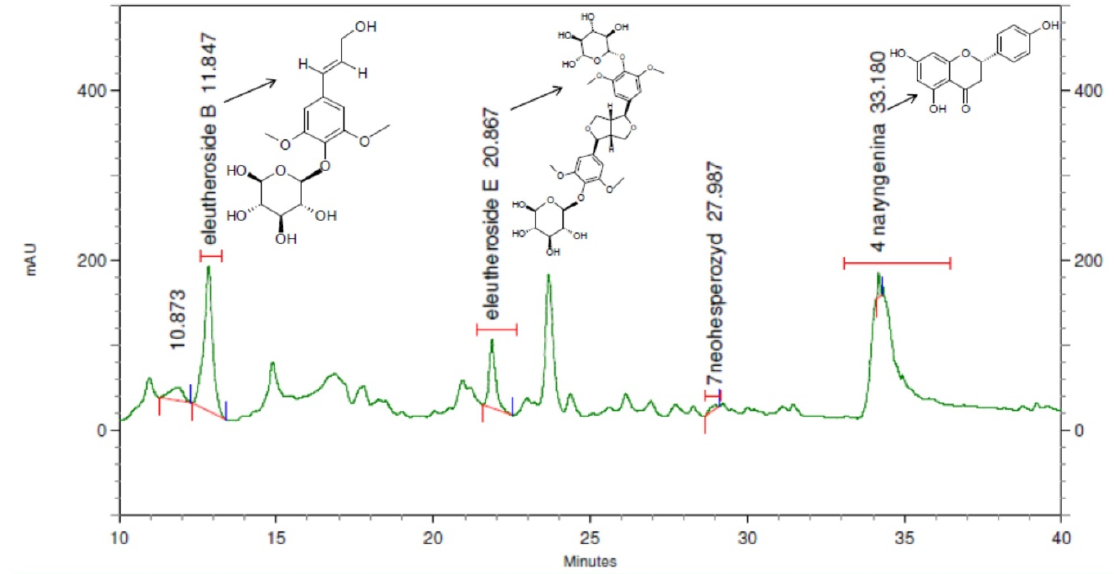
Figure 5. An exemplary chromatogram of the eleutheroside B, E and naringenin in the samples of freshly sourced extract.